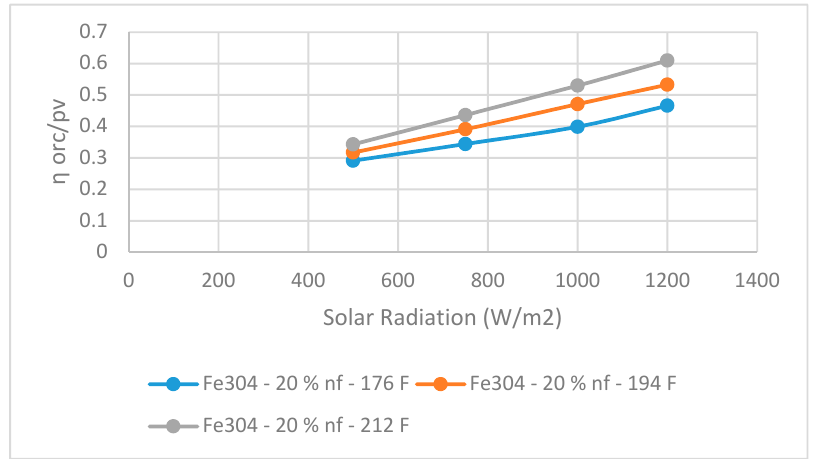
Figure 3. Hybrid system efficiency for Nanofluid SiO 2 at different temperatures and 20% volumetric concentration.